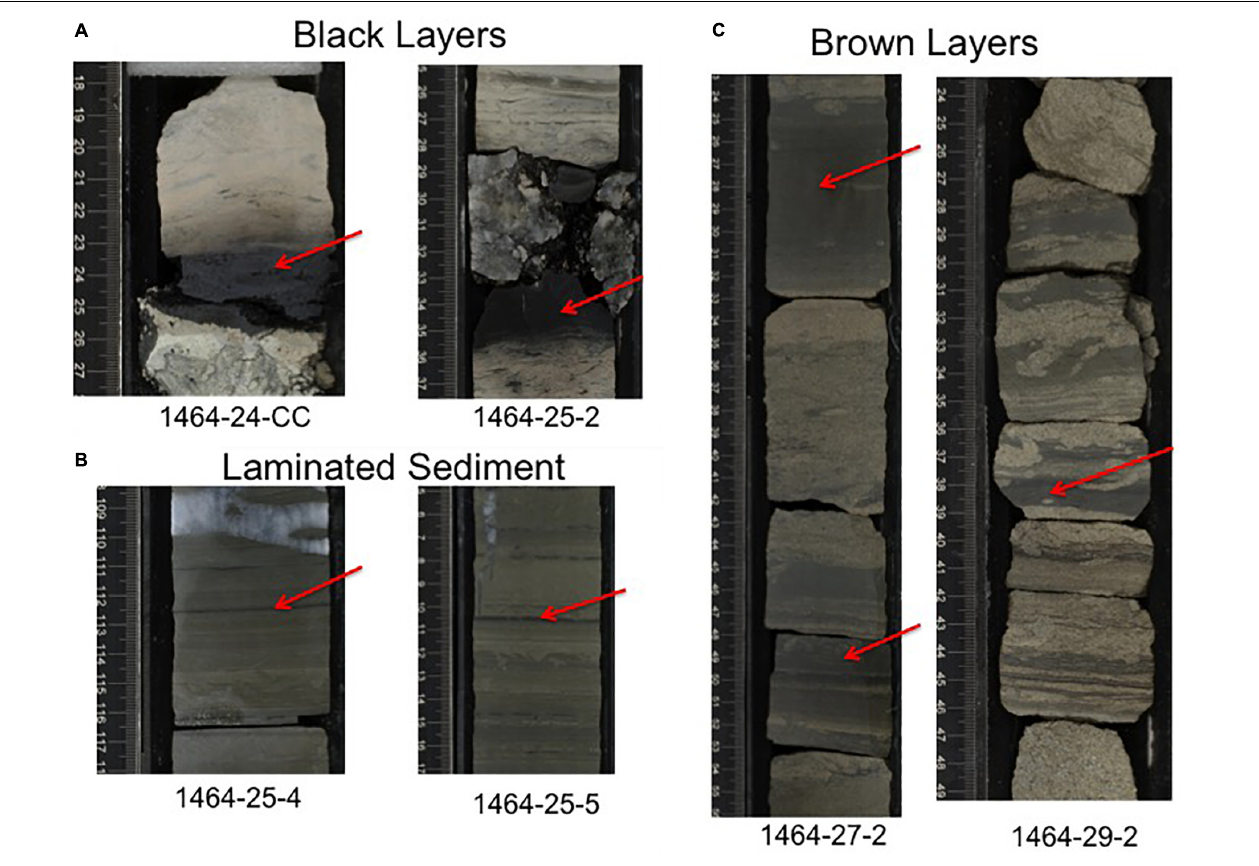
FIGURE 2 | Pictures of the sampling locations for the Miocene sediments from IODP Site 1464C located in western Australia (18 ◦ 03.9244 (cid:48) S, 118 ◦ 37.8942 (cid:48) E). The red arrows represent the location of sampling. The different sediments chosen include (A) black layers, (B) laminated sediment, and (C) brown